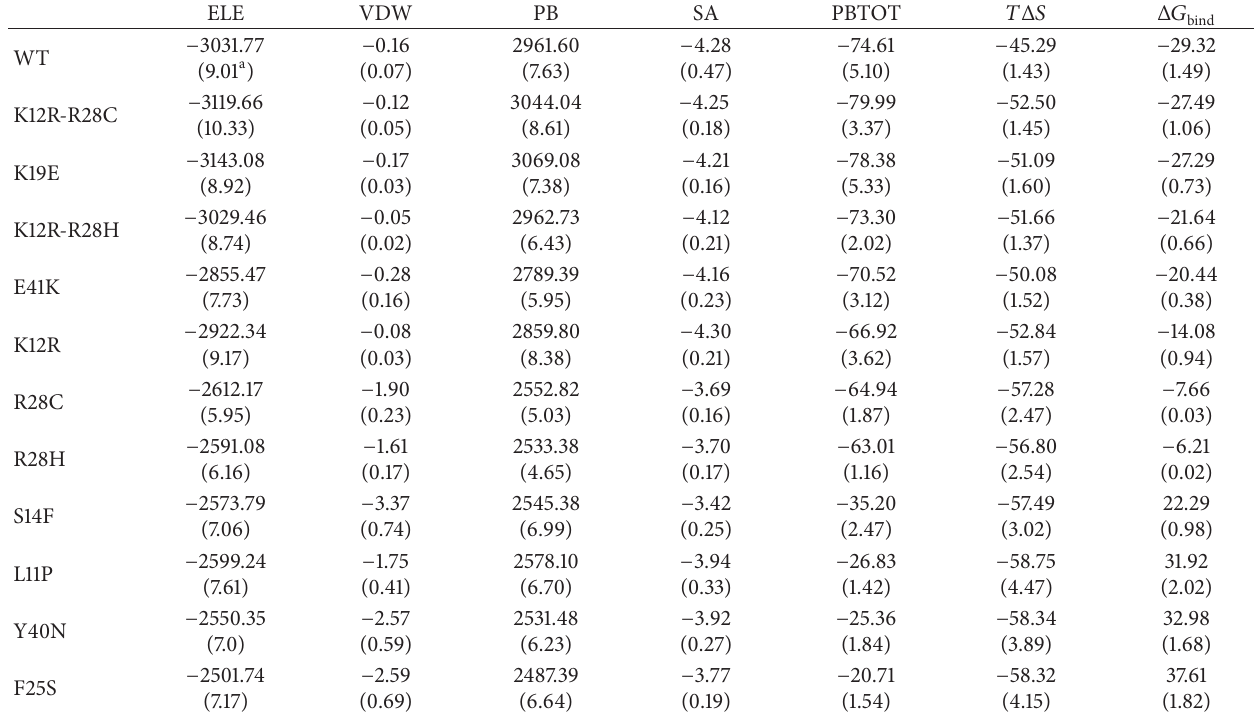
Table 1: Ranked calculated binding free energies (kcal/mol) using MM/PBSA for the twelve protein-ligand